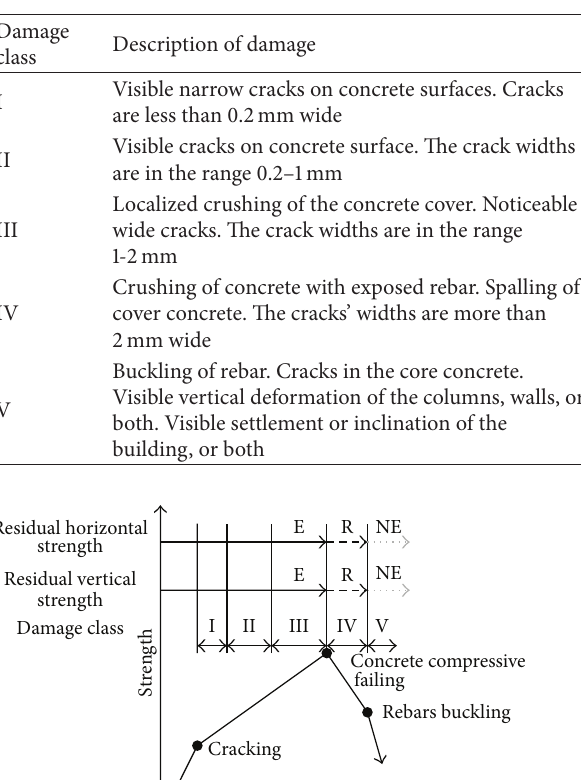
Table 5: Definition of damage classes [7, 32].